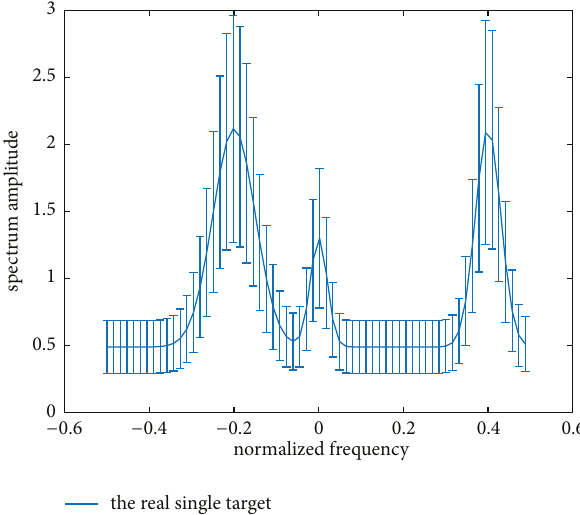
Figure 2: Model of the uncertainty range of single target spectrum.